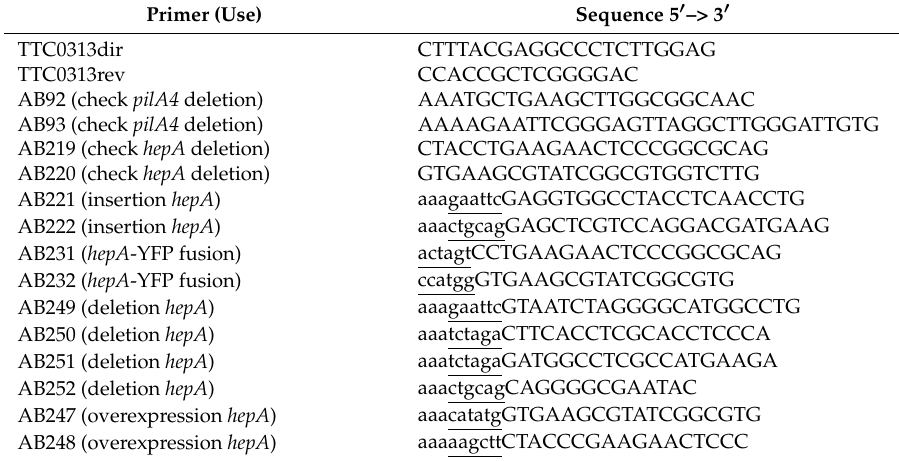
Table 2. Oligonucleotides used in this work. In capital letters, the annealing sequence and, underlined, the cloning restriction site employed.